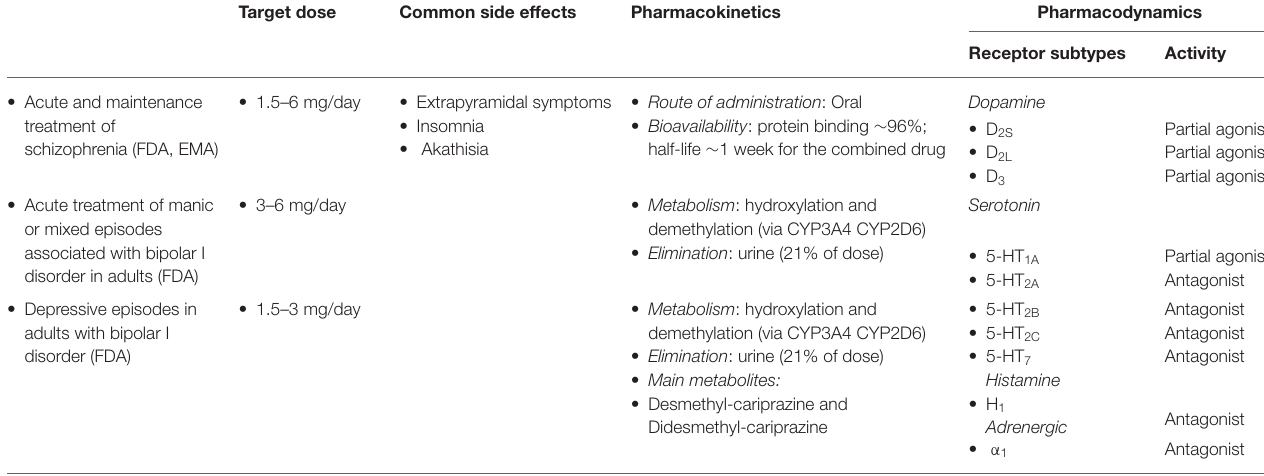
TABLE 1 | Cariprazine clinical